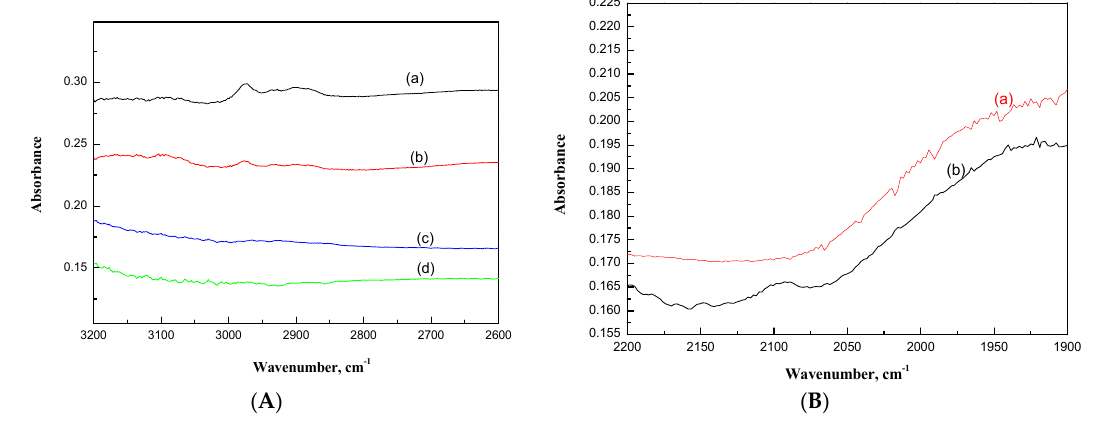
Figure 6. ( A ) FT-IR spectra of carbonaceous species formed on (a) NaYR (LF) , (b) NaYR (HF) , (c) PtR (LF) , (d) PtR (HF) . ( B ) FT-IR spectra of the υ CO stretching region characterizing CO adsorbed on (a) PtR (HF) , (b) PtR (LF) .